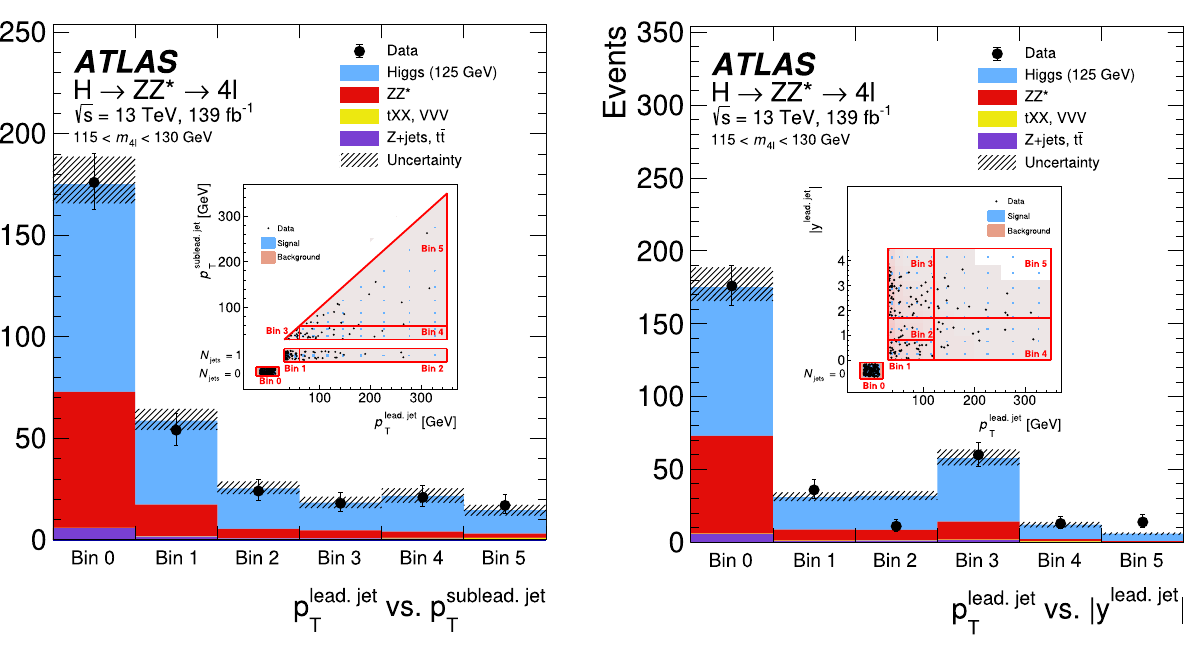
. jet vs. T √ s = 13 TeV.